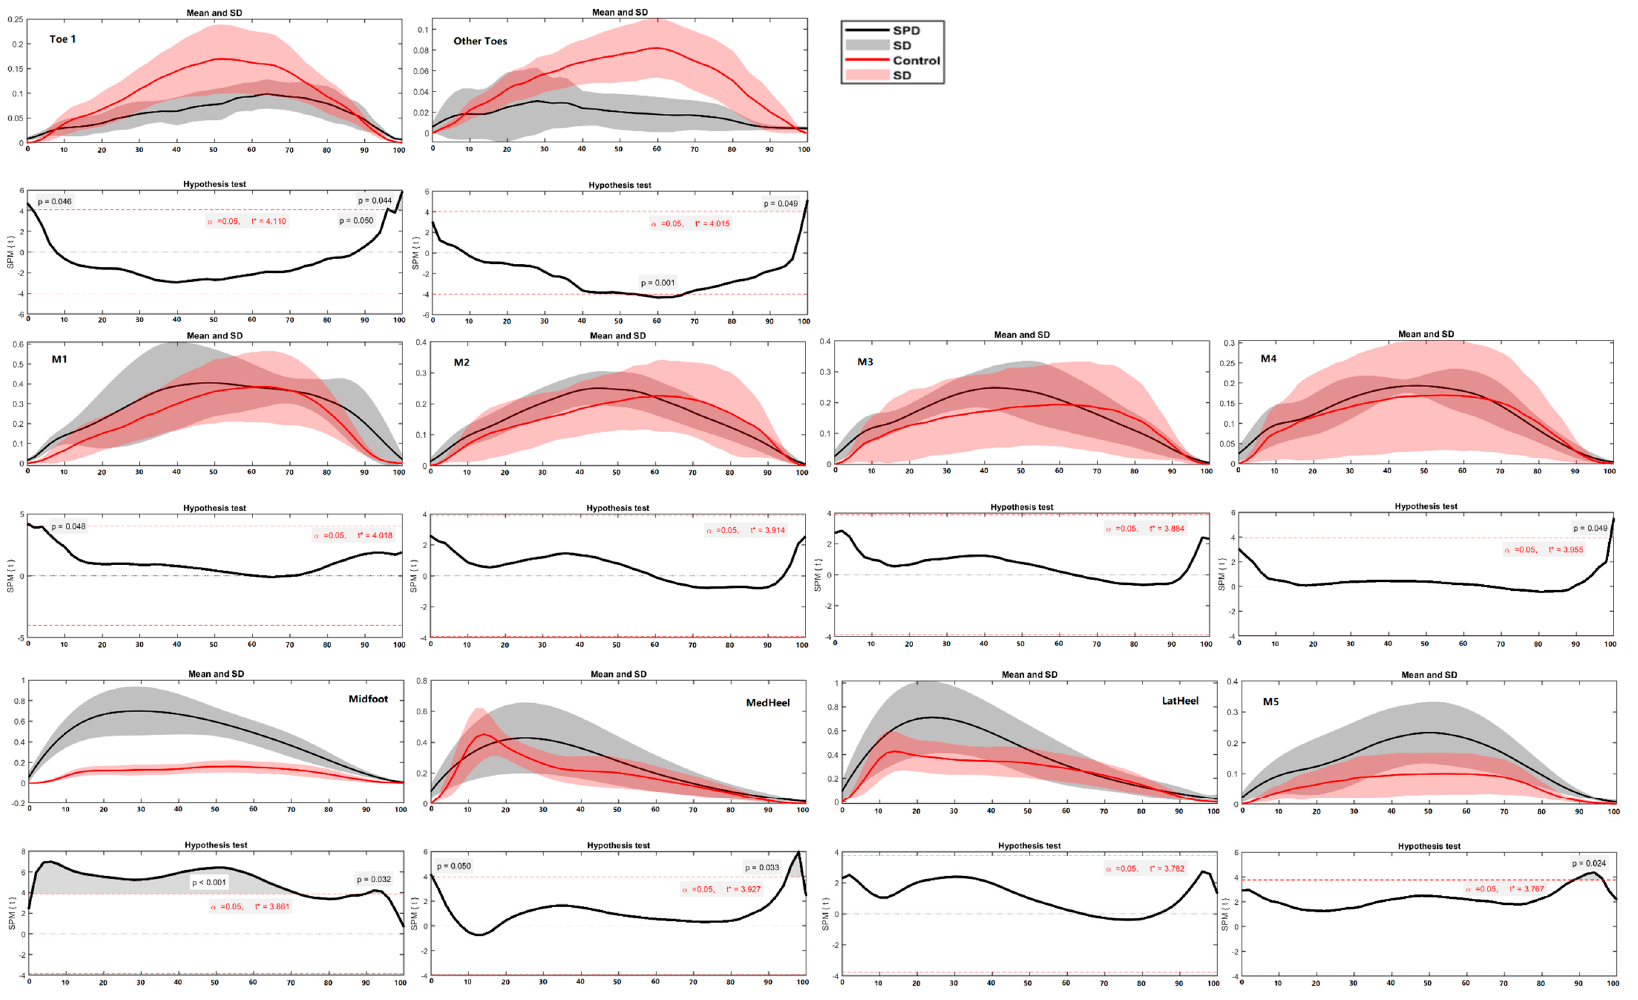
Figure 12. The regional plantar forces in the right foot during turning in the SPD children and healthy controls with highlighted statistics.